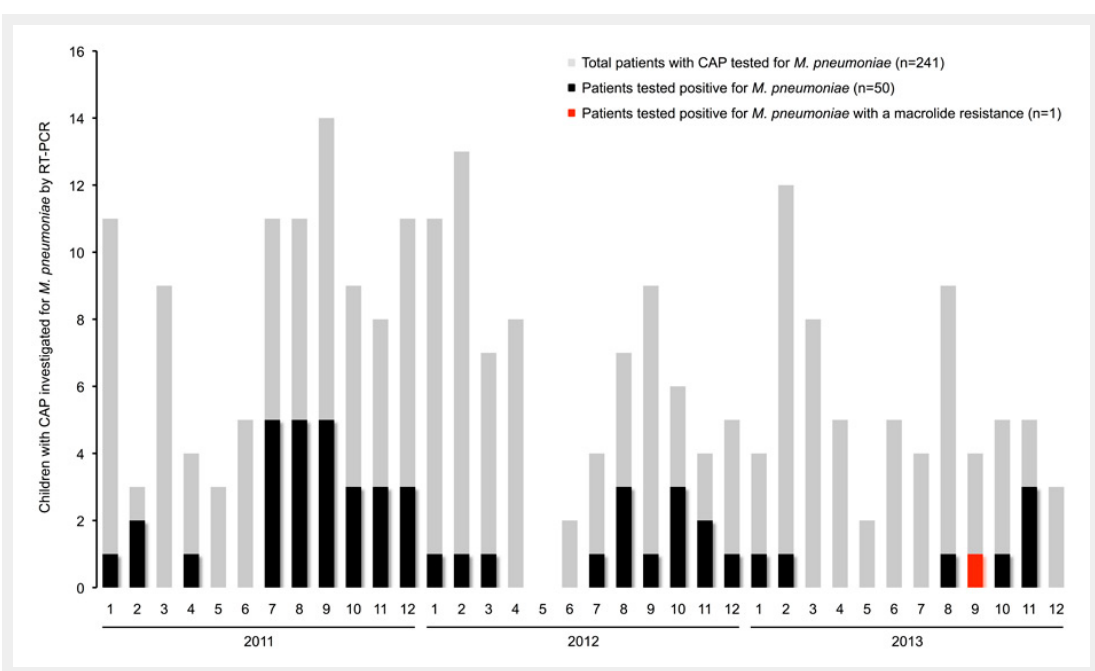
Figure Case distribution of children with community-acquired pneumonia (CAP) investigated for Mycoplasma pneumoniae by real-time polymerase chain reaction (RT-PCR) in respiratory specimens (n = 241) during the study period between 2011 and